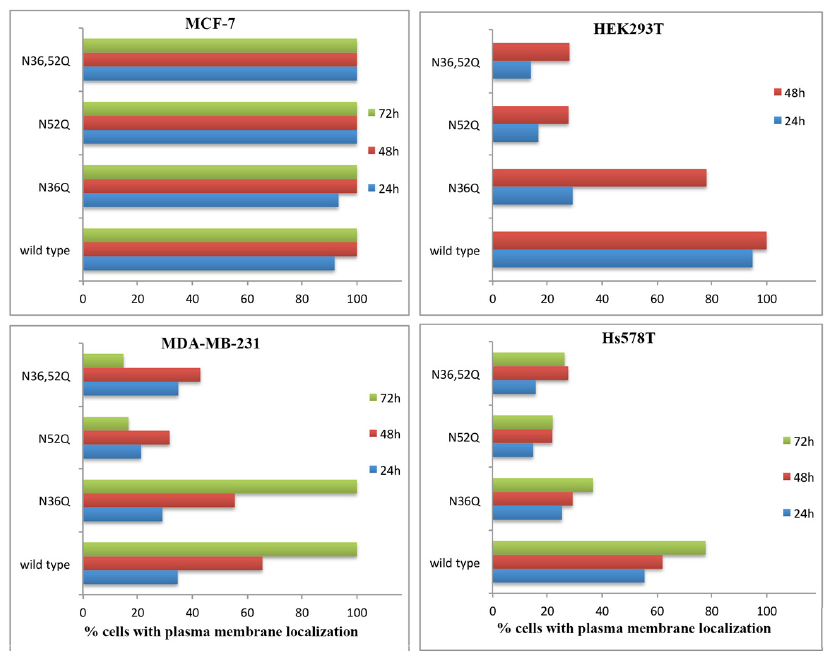
Figure 4. Plasma membrane localization kinetics of wild type, N36Q, N52Q, and N36,52Q CD24 in breast cancer cell lines and HEK293T cells. Diagrams show percentage of cells with plasma membrane localization independently of presence or not of ER-tag CD24 or CD24 mutants at cytoplasmic locations. Statistical analysis is presented in Table S2.